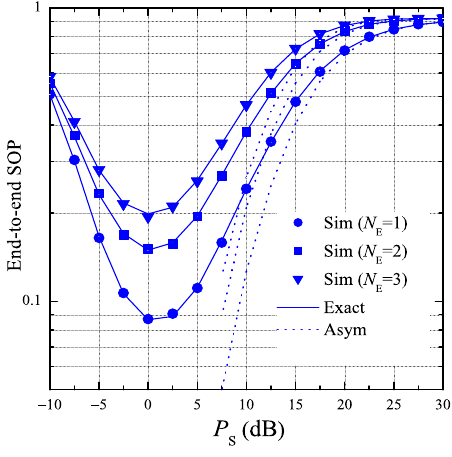
Figure 4. End-to-end secrecy outage probability as a function of P S when K = 3, N D = 2, ε = 0.25, η = 0.25, C th = 0.2, x B = 0.5, y B = 0.3, x P = 0.5, y P = − 0.5, x E = 0.5, y E = 0.5, κ 2